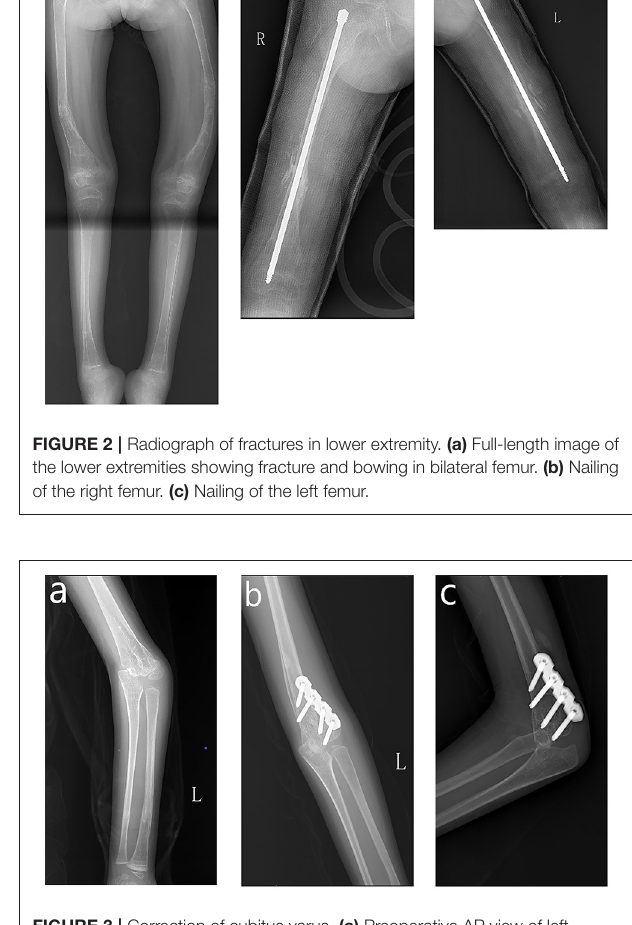
FIGURE 3 | Correction of cubitus varus. (a) Preoperative AP view of left elbow. (b) AP view of the left elbow at 3-month follow-up. (c) Lateral view of the left elbow at 3-month